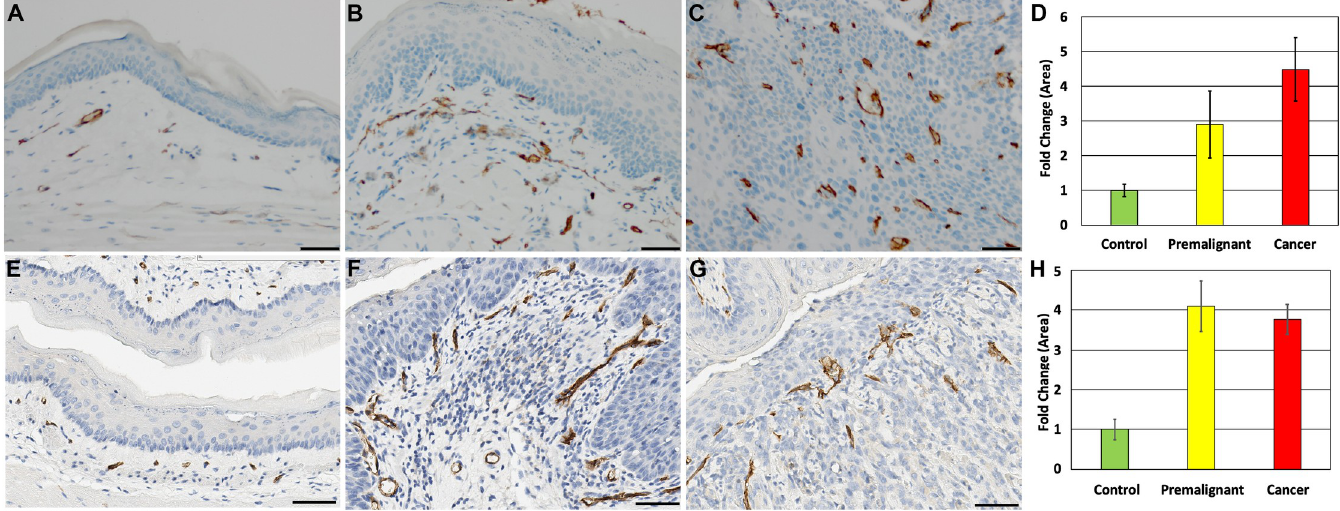
Fig 4. Increased vascular density surrounding DBPDE-induced lesions as well as in p120ctn-null lesions. CD31 staining reveals that there is an increase of vascular development (neovascularization) in the oral tissues of DBPDE-treated mice. (A) CD31 staining of vasculature reveals a regular, single layer of vasculature below the oral cavity epithelium. (B) CD31 increases occur very early and can be seen adjacent to in hyperplastic/mildly dysplastic epithelium. (C) In invasive cancer regions, the vasculature can be seen throughout the tumor. n = 15 for DBPDE mice and n = 10 for controls. (D) Quantification of CD31 staining in DBPDE treated mice as measured by fold difference in CD31 stained area (n = 3). (E) Normal epithelia have a regular vascular pattern underlying the basal layer as measured by CD31. (F) As dysplasia progresses, the blood vessels become very prominent and extend to the tips of the stromal stalks that form. (G) In invasive cancer lesions, the vasculature is fully integrated with the tumor cells. Scale bar = 50uM. n = 5 for p120ctn knockout mice and controls. (H) Quantification of CD31 staining in p120ctn knockout mice as measured by fold difference in CD31 stained area (n =